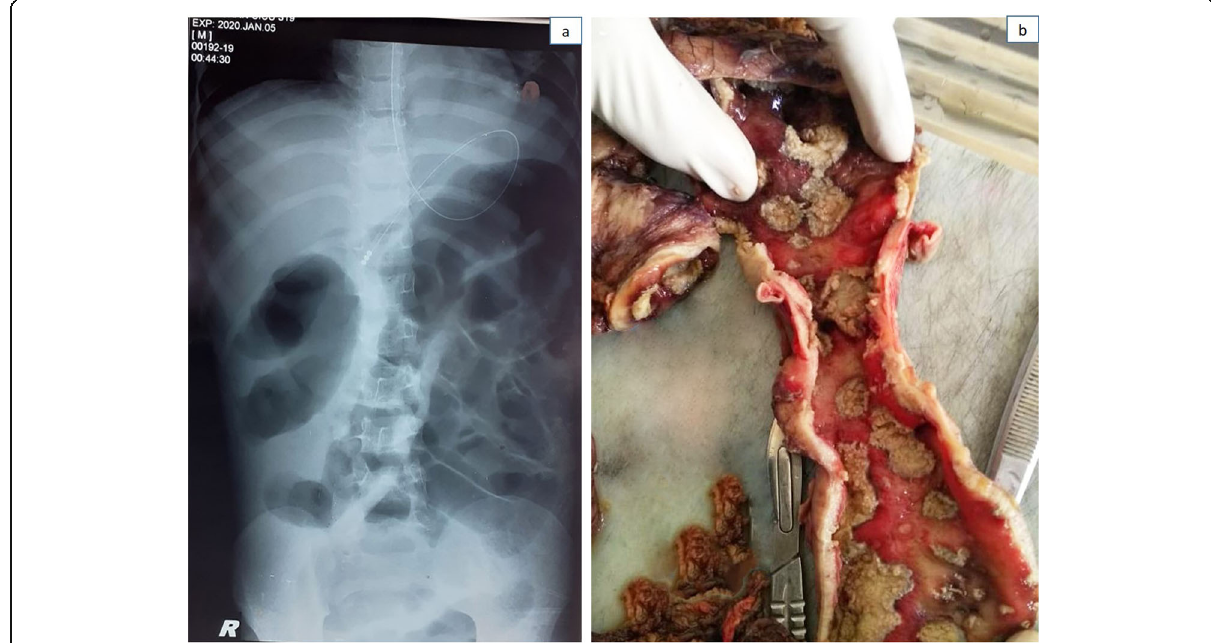
Fig. 1 a X-ray image of the patient ’ s abdomen. The dilated bowel loops can be seen. b Section of the colon showing widespread amebic